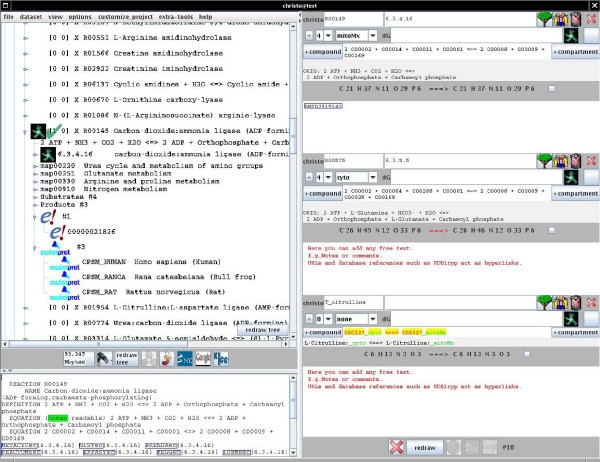
Screen-shot of the application. The upper left part shows KEGG-data as a graphical tree. The tree node of the reaction R00149 is expanded. The traffic light icon indicates that this reaction node has at least one dataset. The sub-nodes of R00149 contain information on the EC-number 6.3.4.16, the biochemical pathway maps where this reaction is contained, the four substrates and three reaction products, the ENSEMBL entry ENSG00000021826 and the three SWISSPROT entries. The lower left panel contains the textural description of the reaction. Words with a blue frame act as hyperlinks. The right part shows datasets for the two carbamoylphosphate synthetases R00149 and R00575 and the transport of citrulline across the inner mitochondrial membrane. The biochemical equation for R00149 and R00575 were taken from KEGG and the equation for the transport process was entered manually. The red arrow in R00575 indicates that there is a slight error in the equation. The left side of the equation has an hydrogen less than the right side. This can be corrected by adding " + H+" into the equation. The "H+" will automatically be replaced by "C00080". One can also use the button [compound] to select hydrogen from a list of compounds.